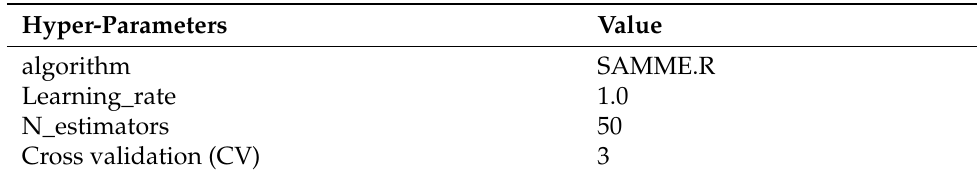
Table 11. Input Parameters for Adaboost.